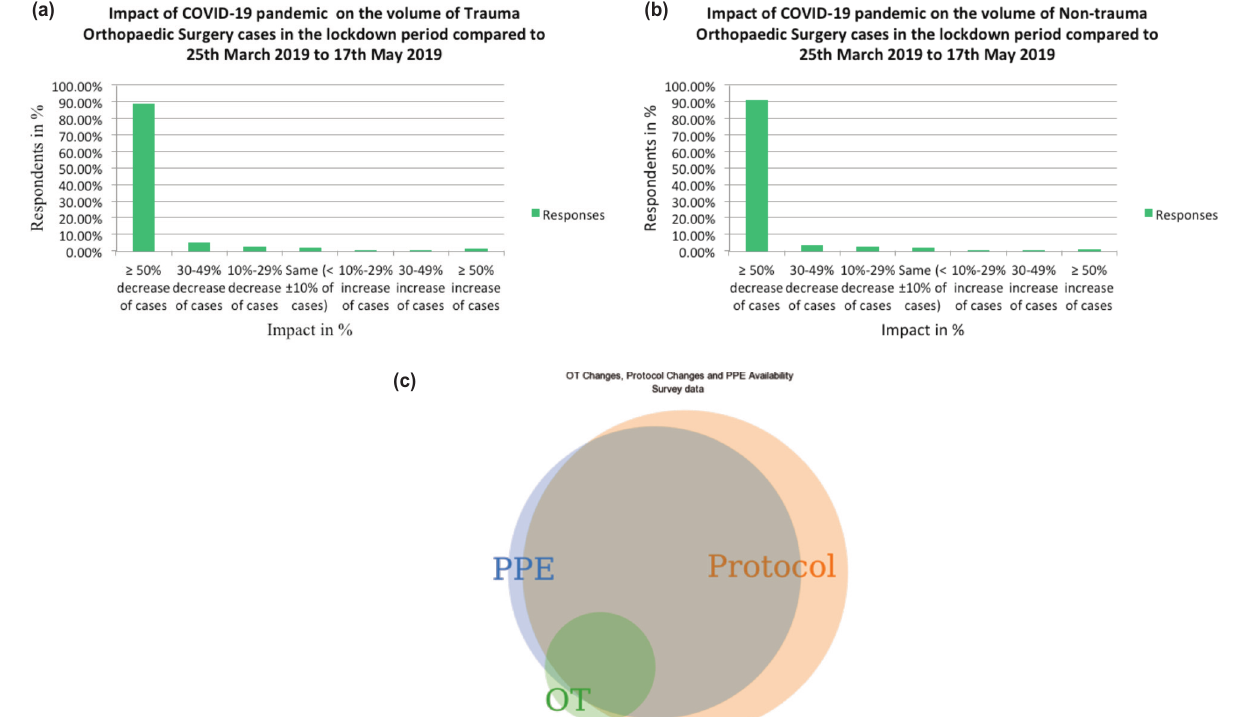
(a) Impact of COVID-19 pandemic on the volume of Trauma Orthopaedic Surgery cases in the lockdown period compared to 25th Fig. 1: March 2019 to 17th May 2019. (b) Impact of COVID-19 pandemic on the volume of Non-trauma Orthopaedic Surgery cases in the lockdown period compared to 25th March 2019 to 17th May 2019. (c) Association between OT changes, Hospital protocol changes and PPE’s availability undertaken during COVID-19.